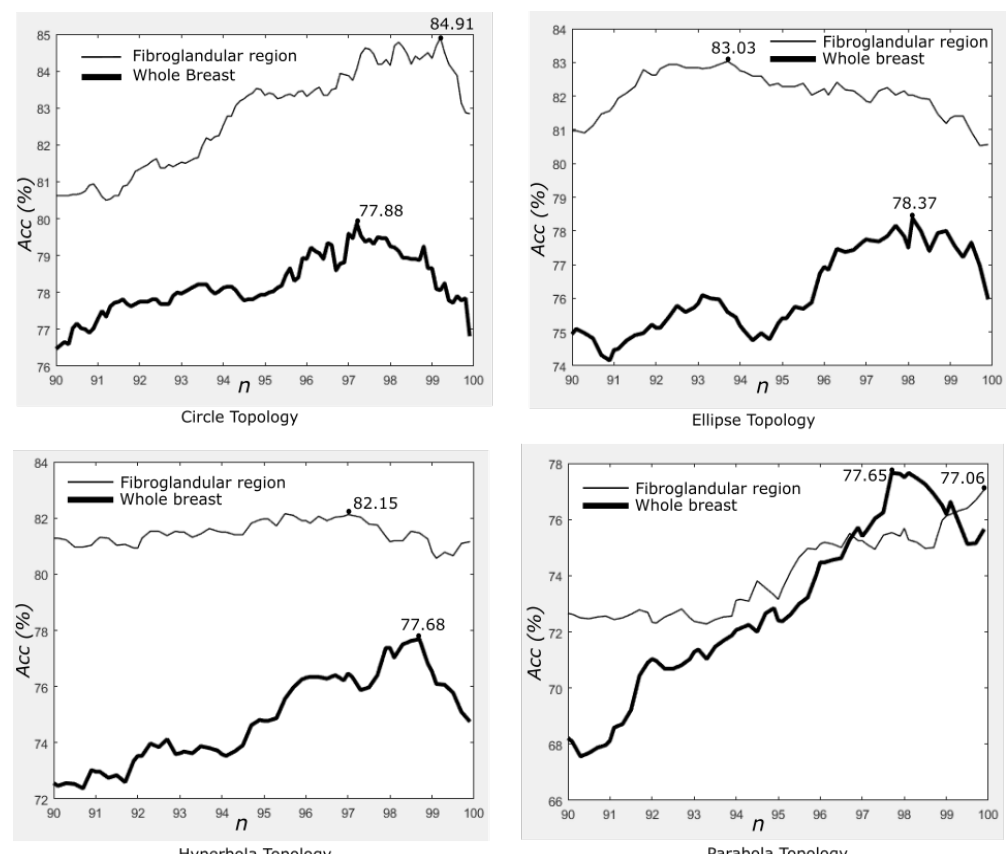
Figure 12. Quantitative results based on features extracted from the whole breast versus fibro-glandular disk region covering four different topologies. Note that the x- axis and y- axis represent the accuracy (percentage of correctly classified cases) and the percentage of dominant patterns, respectively.